Question: Generate an informative caption for the figure above.
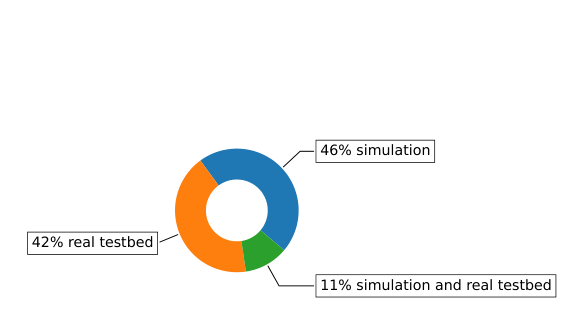
Answer: Percentages of research articles evaluating their methods by simulation, real testbed, or both tools.